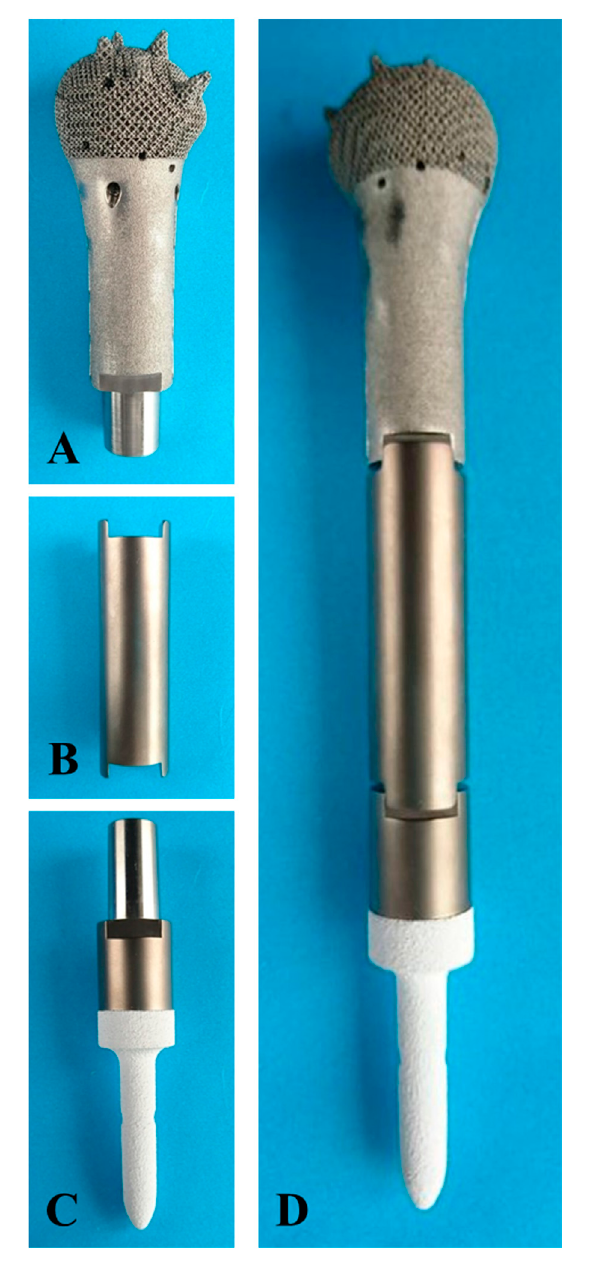
FIGURE 3 Fabricated prosthesis pictures. (A) Prosthesis head. (B) Prosthesis shaft. (C) prosthesis stem. (D) Assembled